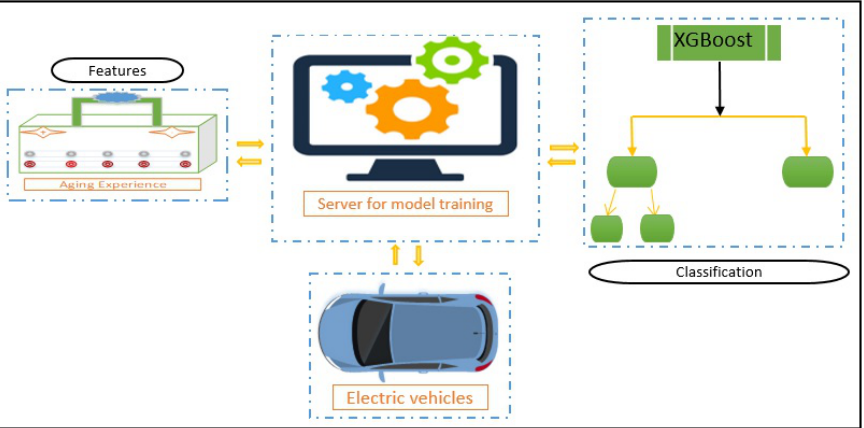
Figure 3. The framework of the proposed